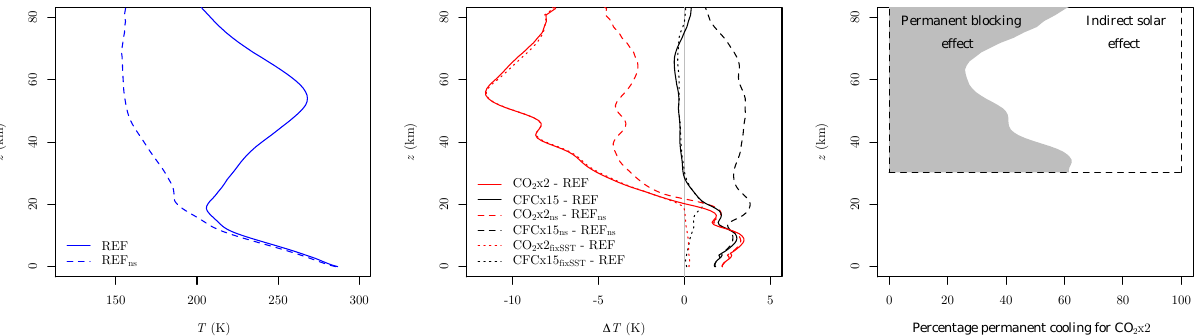
Figure 9. Results obtained with ECHAM6 coupled to a simplistic ocean model to allow for rapid thermal adjustment of the surface. Left: global annual-mean equilibrium temperature profiles for two reference runs under pre-industrial external forcing, with (solid; REF) and without (dashed; REF ns ) absorption of solar radiation in the atmosphere. Middle: temperature difference to the corresponding reference runs in response to increased CO 2 or CFC concentrations (simulation IDs are explained in Table 1). Right: percentage of the permanent cooling effect in response to CO 2 doubling from the blocking and indirect solar effects, estimated by dividing CO 2 × 2 ns − REF ns by CO 2 × 2 − REF. Note that the vertical coordinate z is only approximate height, calculated from h with a constant scale height H = 8km such that h = 1 − e − z/H